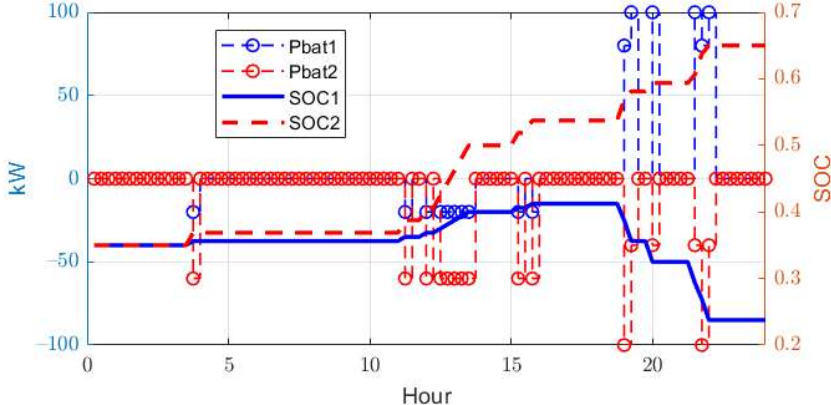
Figure 5. Battery energy storage systems (BESSs) operation results.